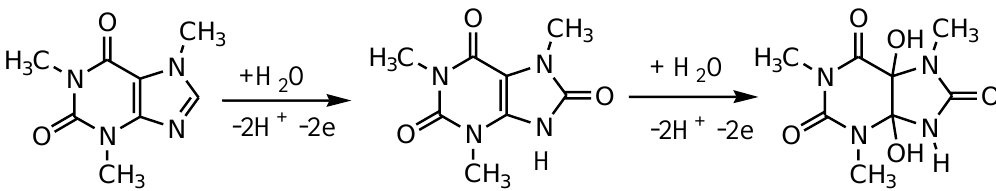
Figure 2. Steps of the caffeine oxidation reaction in an acidic environment, proposed by Tadesse, Y., et al [25].